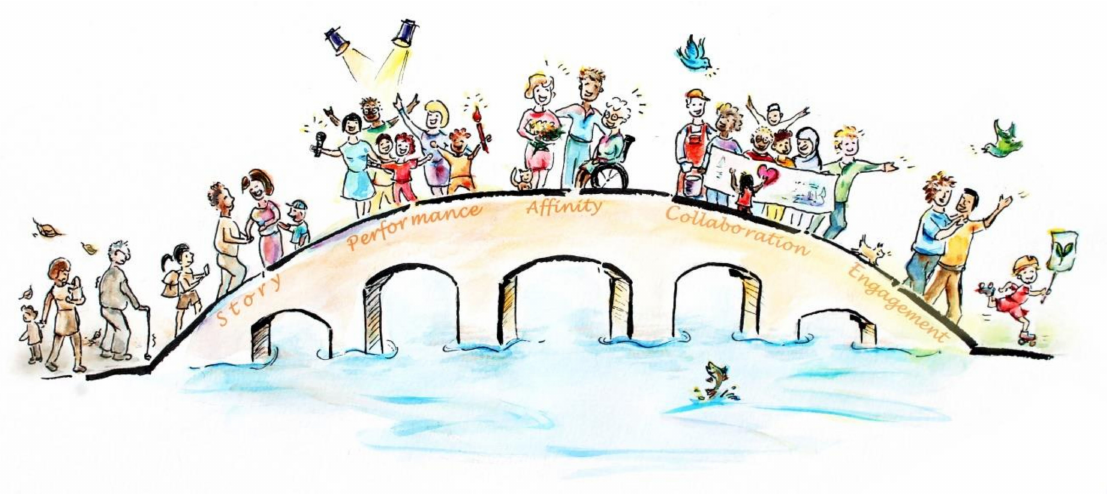
Figure 1. Researcher illustration of the Story Bridge SPACE